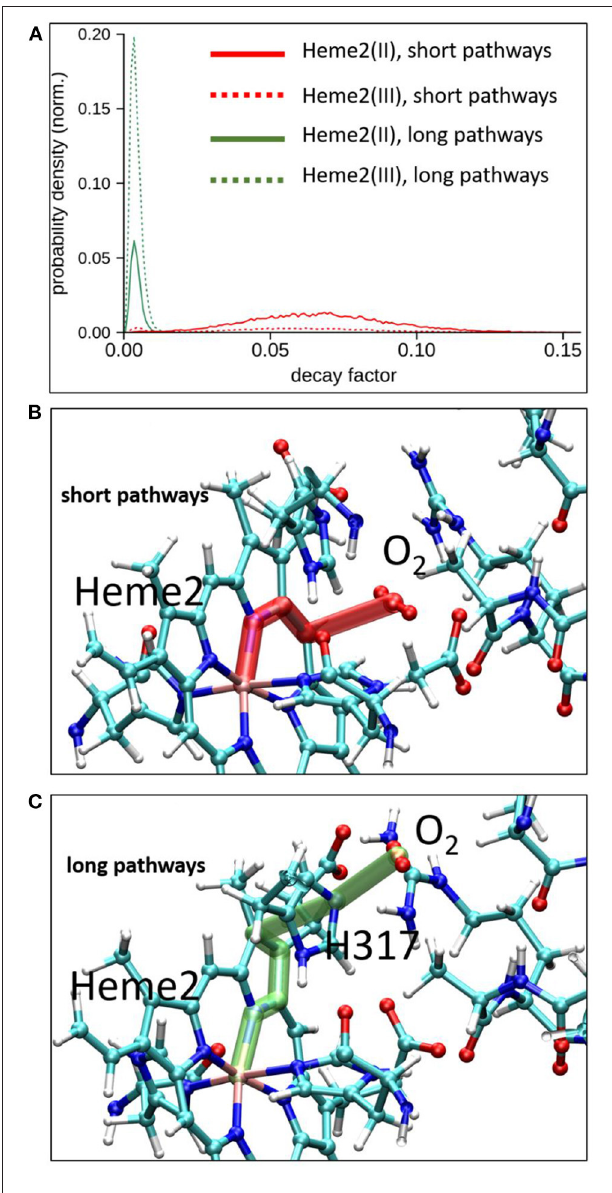
FIGURE 8 | Electron tunneling pathway analysis between Heme2 and the dioxygen molecule. Top, normalized distributions of decay factors collected along the MD simulations in initial and final redox states of the inter-heme ET [(Heme2(III)) and Heme2(II) respectively]. Middle and bottom, representative snapshots of the two dominant pathways encountered during MD